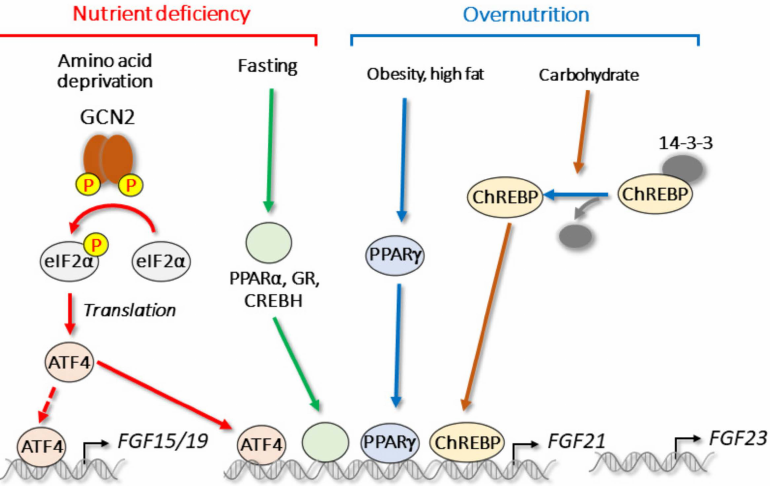
Figure 6. Nutrient stress and endocrine FGFs. Both nutrient deficiency and overnutrition regulate endocrine